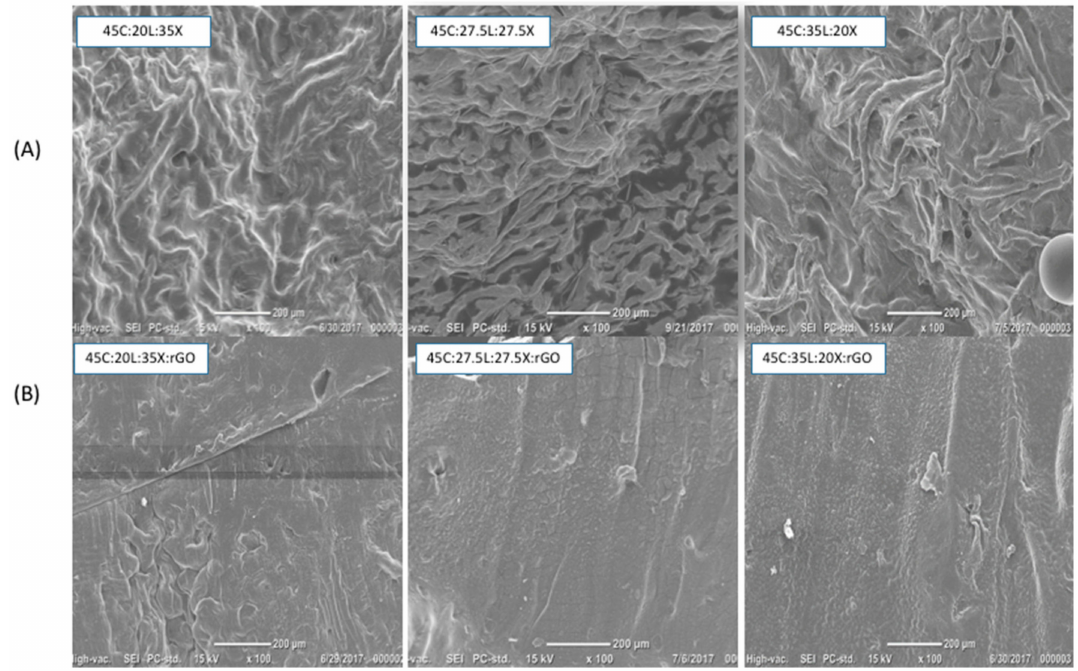
Figure 2. SEM images: ( A ) lignocellulosic blended films and ( B ) lignocellulosic blended films with